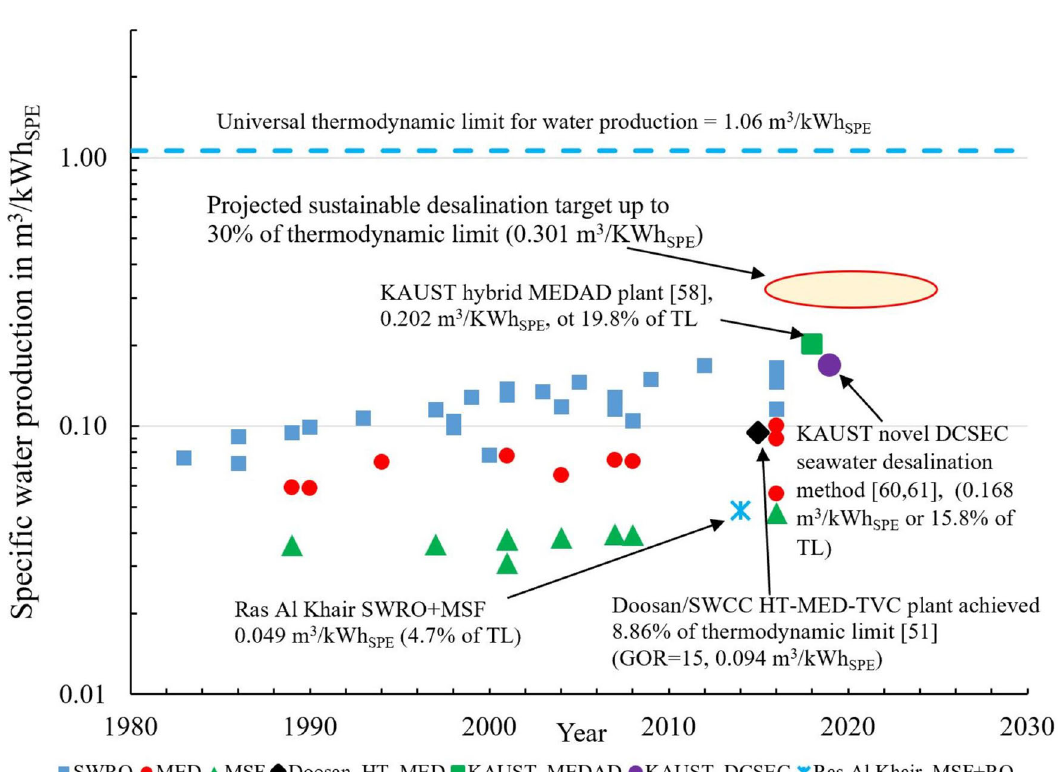
Fig. 6 Energy ef fi ciency comparison of seawater desalination processes. Energy ef fi ciency comparison of seawater desalination